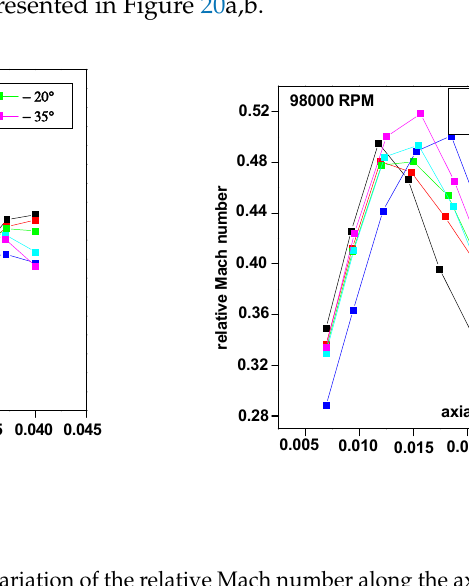
Figure 20. The variation of the relative Mach number along the axial direction of the flow for different deviation blade angles: ( a ) relative Mach number for different deviation blade angles at 75% rotation speed; ( b ) relative Mach number for different deviation blade angles at 100% rotation speed.